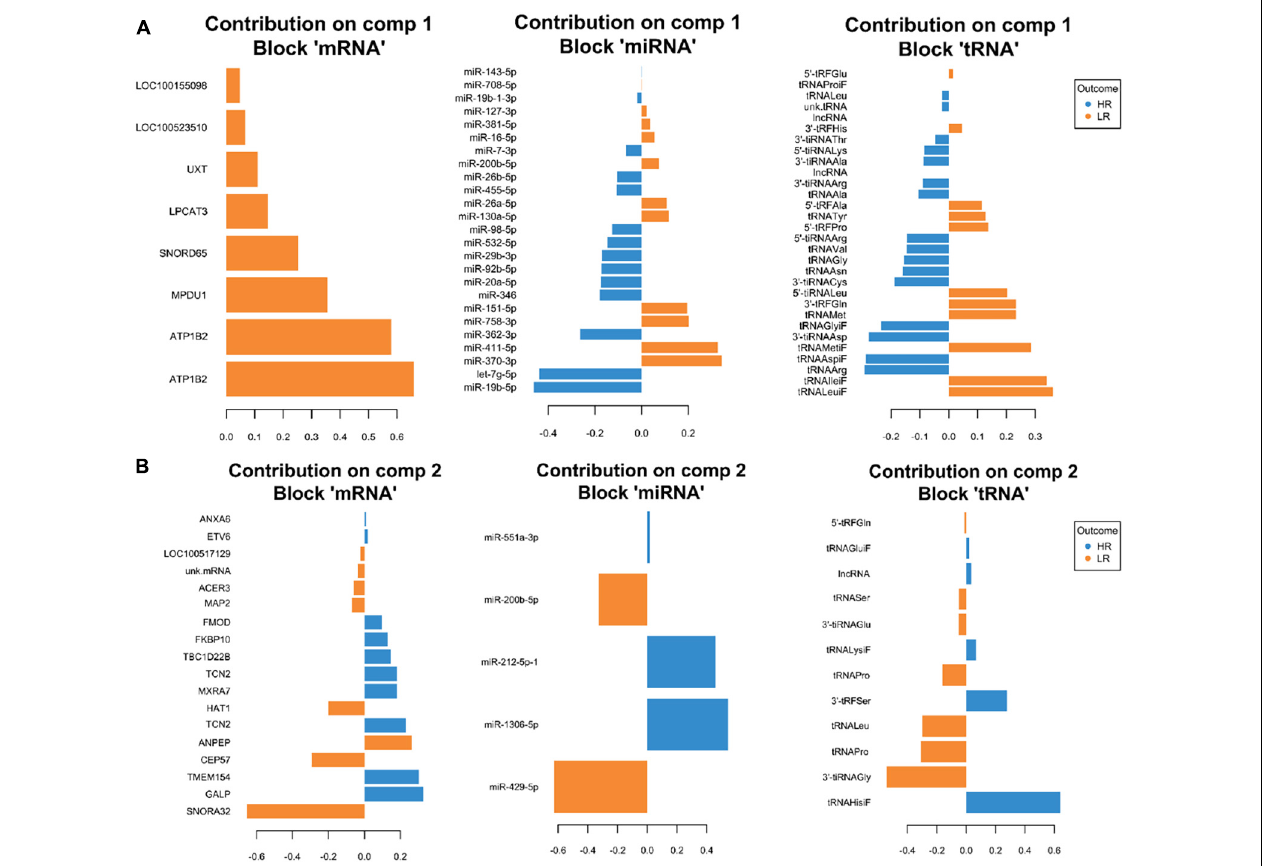
FIGURE 2 | Representation of the optimal biomarker panel of mRNA, miRNA, and tRNA correlated to coping behavior haplotype groups over two component sets in the adrenal gland. DIABLO minimal set of feature selection across data types could discriminate between high-reactive (HR) and low-reactive (LR) groups in component 1 (A) and component 2 (B) . Blue-colored bars are indicators for the HR group, yellow-colored bars indicate the LR group (DIABLO: Data Integration Analysis for Biomarker discovery using Latent